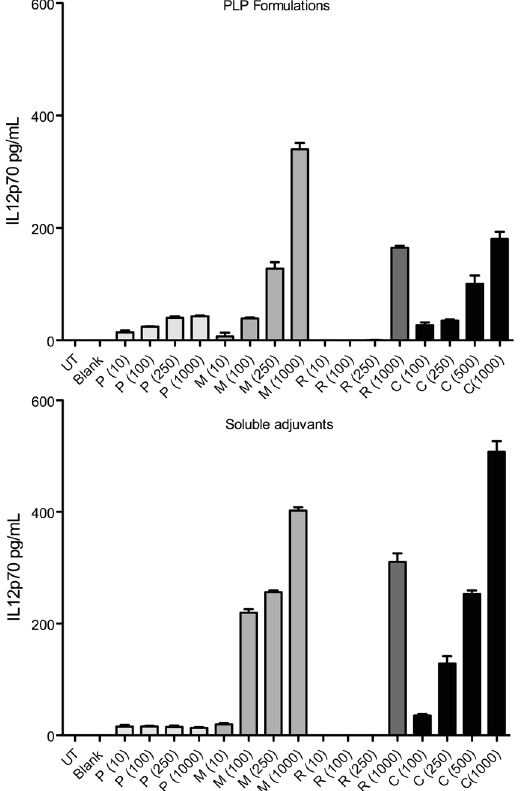
Figure 1. Adjuvant dose response study. BMDCs derived from C57BL/6 J mice were exposed to medium alone (UT) or treated with blank PLP (Blank) or increasing doses of PLP formulations or soluble Pam3CSK4 (P), MPLA (M), R837 (R) (10 ng mL − , 100 ng mL − , 250 ng mL − , or 1000 ng mL − ) or CpG (C) (100 ng mL − , 250 ng mL − , 500 ng mL − , or 1000 ng mL − ). At 24 h post exposure, cell-free supernatants were harvested and assayed for IL12p70 by ELISA. Data are represented as mean ± SEM of 4